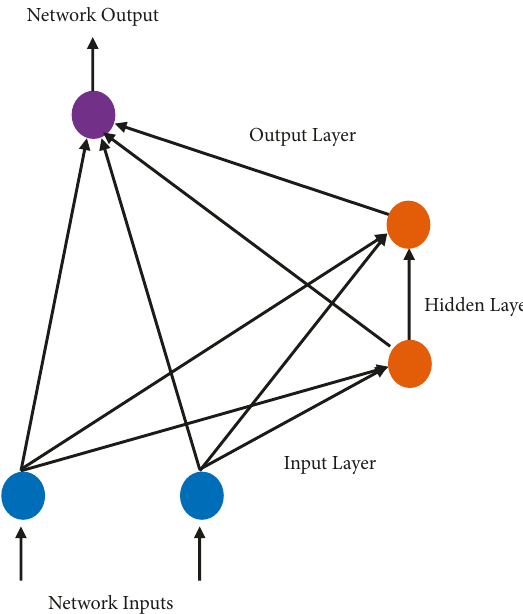
Figure 1: Cascade correlation neural